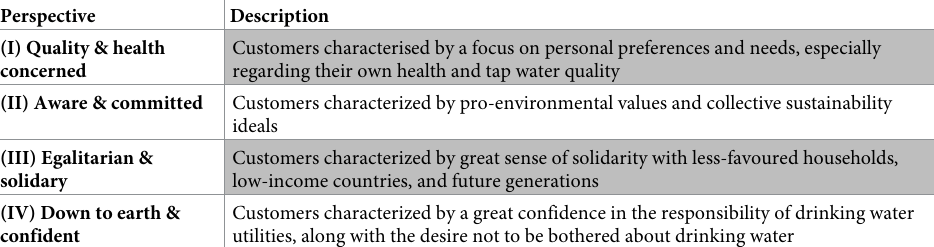
Table 1. Customer